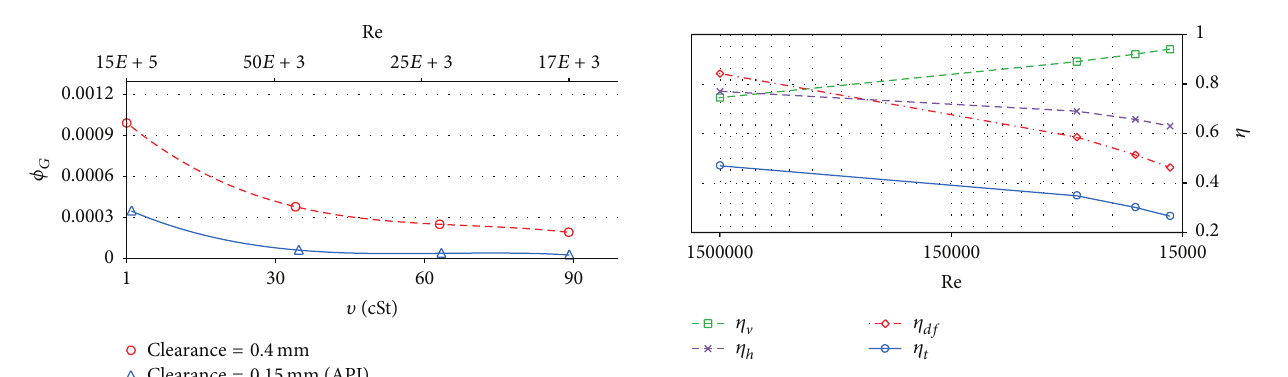
Figure 13: Efficiency as a function of Reynolds number, based on CFD results. Table 4: The effect of oil viscosity on pump efficiency, based on CFD